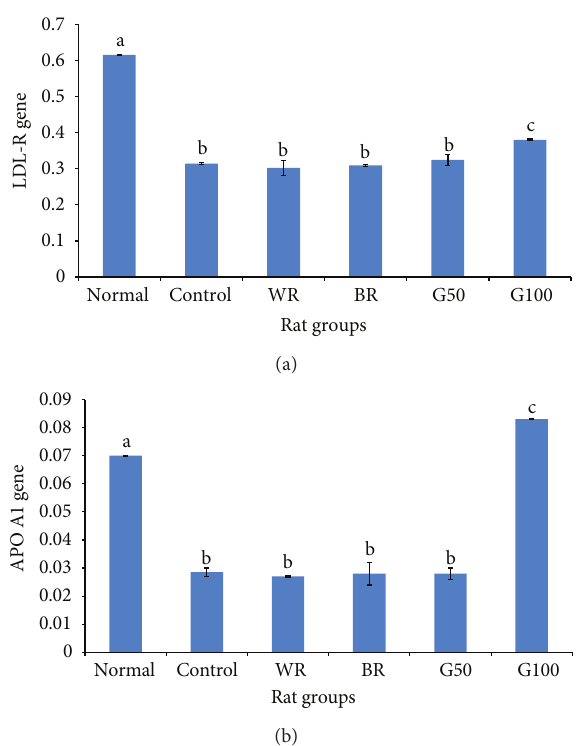
F 2: Changes in rat hepatic expression of (a) the low-density F 3: Changes in the expression levels of (a) the low-density lipoprotein receptor (LDL-R) gene and (b) the apolipoprotein A1 lipoprotein receptor (LDL-R) gene and (b) the apolipoprotein A1 (APO A1) gene aer 4 weeks of the dietary intervention. e �gure (APO A1) genes in HEPG2 cells following 24h of treatment. e shows the effect of germinated brown rice (GBR) on the expression �gure shows the effect of �0ppm of acylated steryl glycoside (ASG), levels of the LDL-R and APO A1 genes in type 2 diabetic rats aer -amino butyric acid (GABA), oryzanol, and phenolic extracts on 4 weeks of the intervention compared with the effects of brown rice the expression levels of LDL-R and APO A1 genes in HEPG2 cells (BR) and white rice (WR) ( /group). e data represent the following 24h of treatment compared with the effects of insulin 𝛾𝛾 means of each group, and the error bars represent the SDs. Bars with (100nM) and no treatment ( ). e data represent the Bioactive different letters are signi�cantly different ( ). e groupings means of each group, and the error bars represent SDs. 𝑛𝑛 𝑛 𝑛 Bioactive group group signi�cantly higher than the control group. are the same as in Figure 1. 𝑛𝑛 𝑛 𝑛 ∗ signi�cantly higher than the insulin group ( 𝑃𝑃 𝑃 𝑃𝑃𝑃𝑛 ∗∗ 𝑃𝑃 𝑃 𝑃𝑃𝑃𝑛